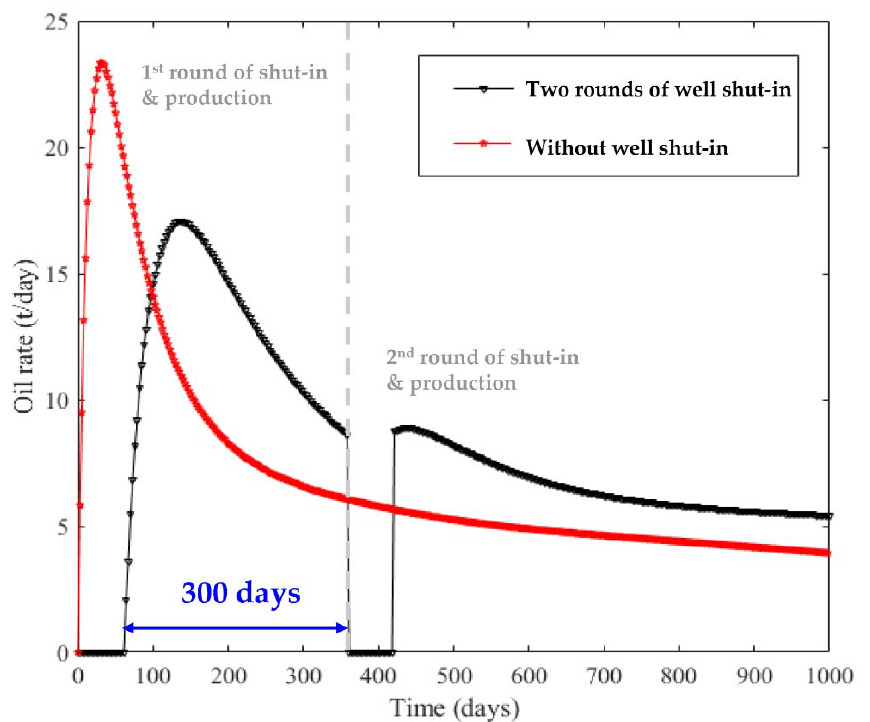
Figure 17. Daily oil rate with 300 days of first round of production.